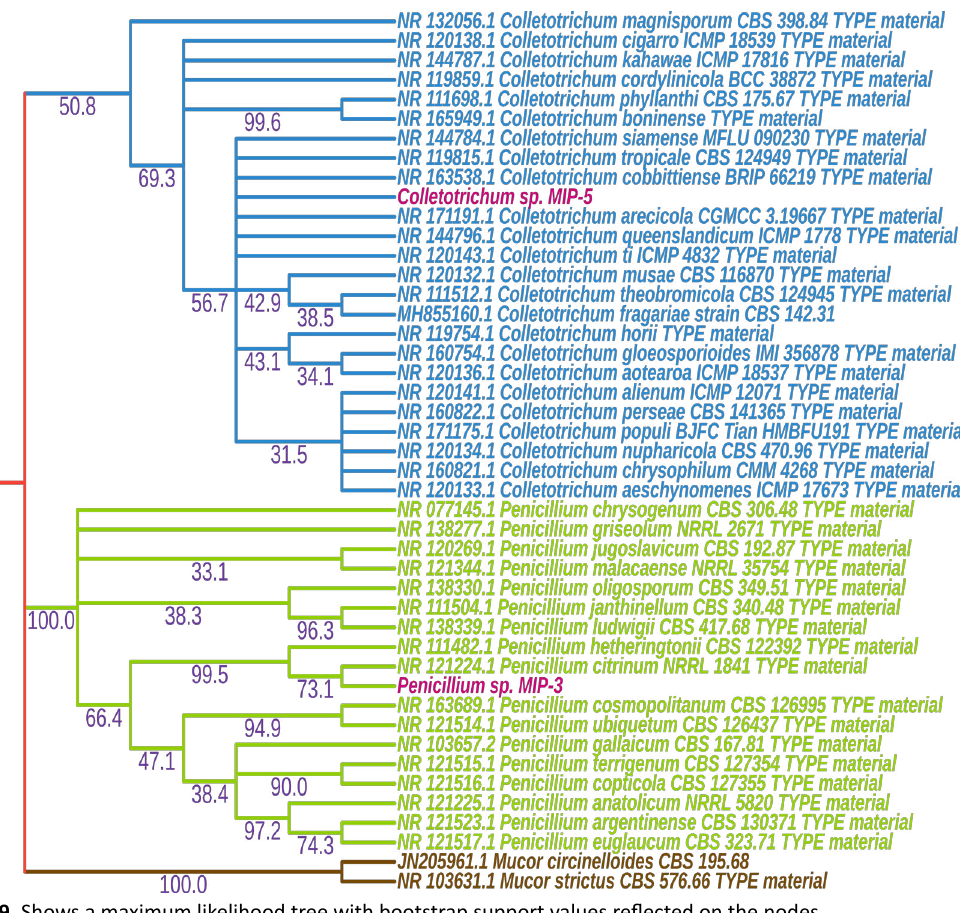
Fig. 8. Shows the culture and spore (50x magnification) morphology of the fungal isolates on PDA. ( A , B ) Colletotrichum sp MIP-5 (C, D) Penicillium sp.